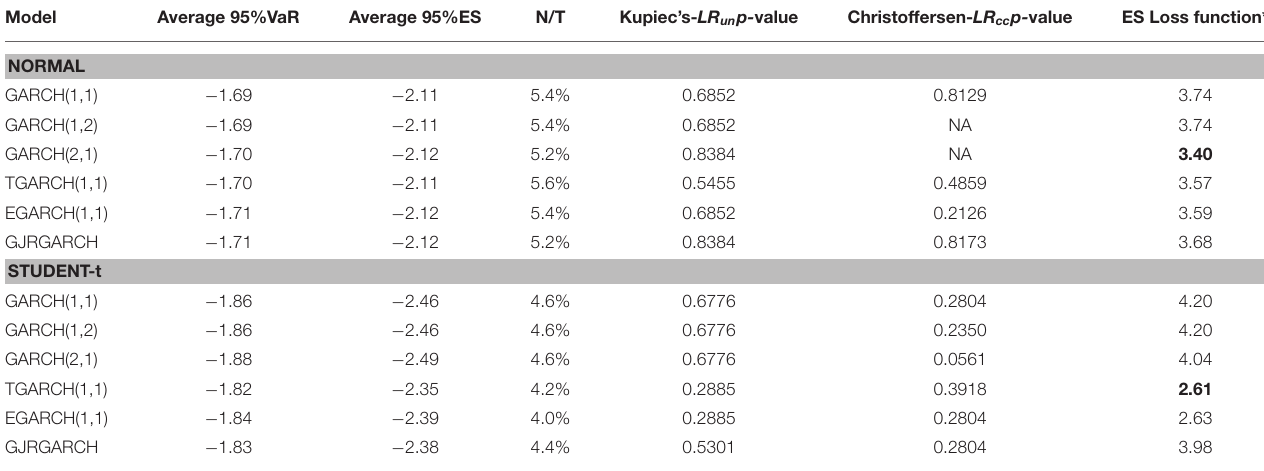
TABLE 9 | DAX equity index: 95%VaR and 95%ES average values of one-day-ahead forecasts, percentages of violation (N/T), Kupiec’s and Christoffersen’s p-values and ES loss function.